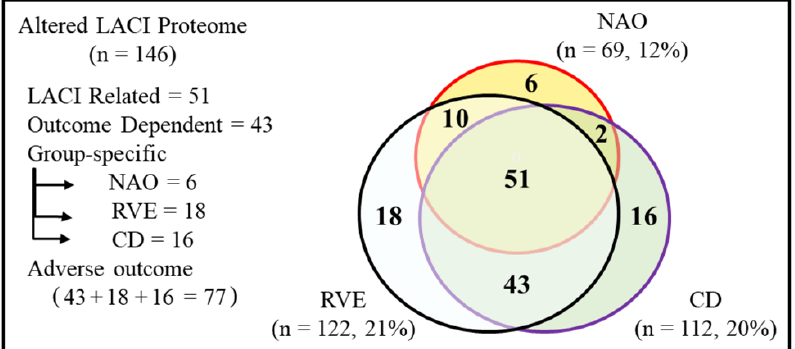
Figure 3. Venn diagram comparing altered proteins quantified by iTRAQ experiment in different LACI groups. A total of 146 out of 573 quantified proteins were used for this analysis. NAO, no adverse outcome; RVE, recurrent vascular event; CD, cognitive decline.